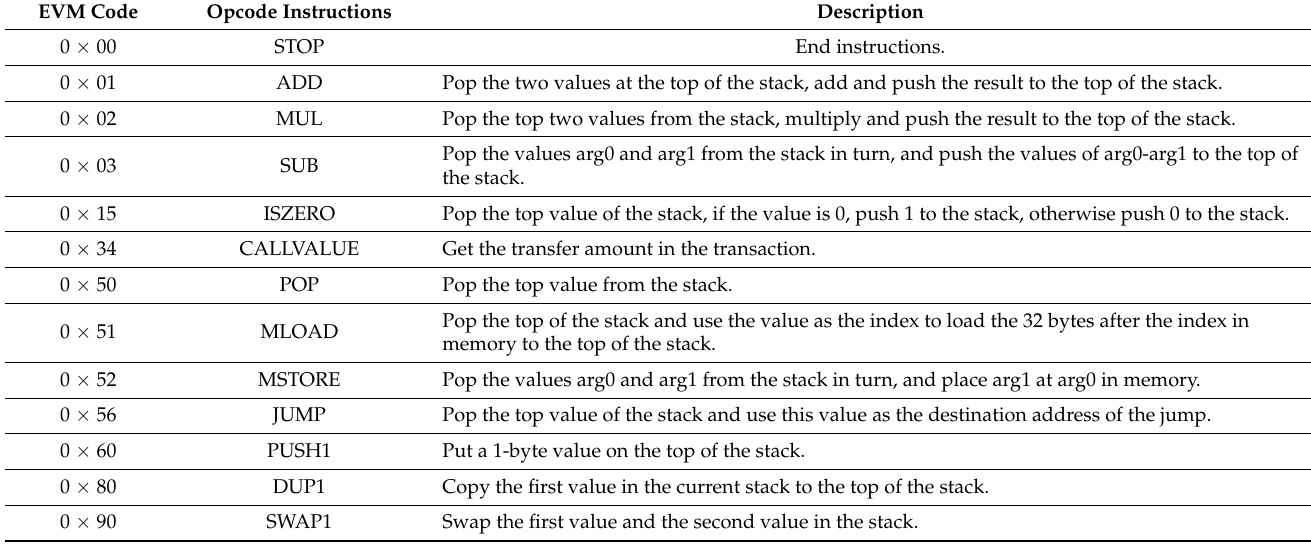
Table 2. Common assembly